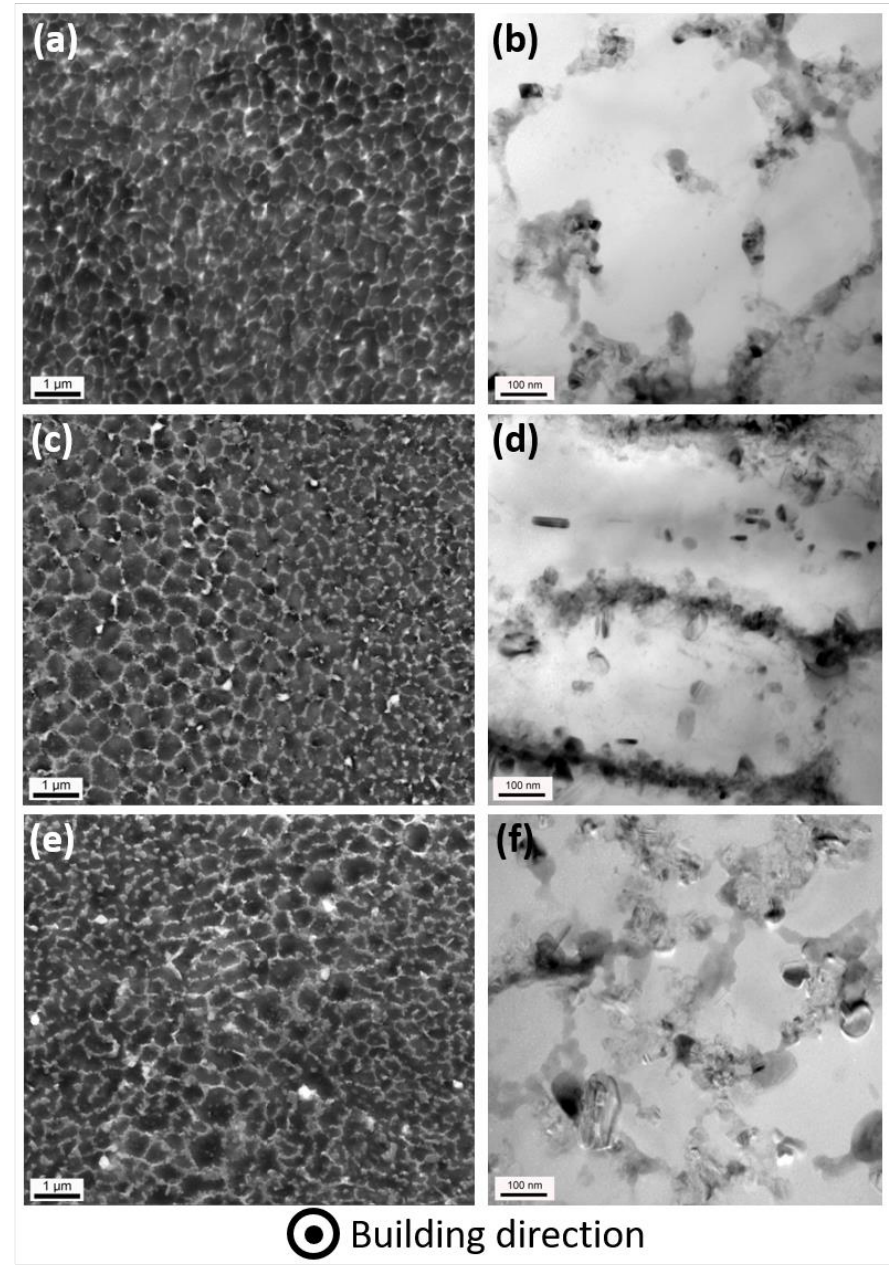
Figure 4. ( a , c , e ) SEM and ( b , d , f ) TEM micrographs of ( a , b ) as-built and annealed samples for ( c , d ) 8 h and ( e , f ) 64 h. All micrographs depict the XY section of the considered